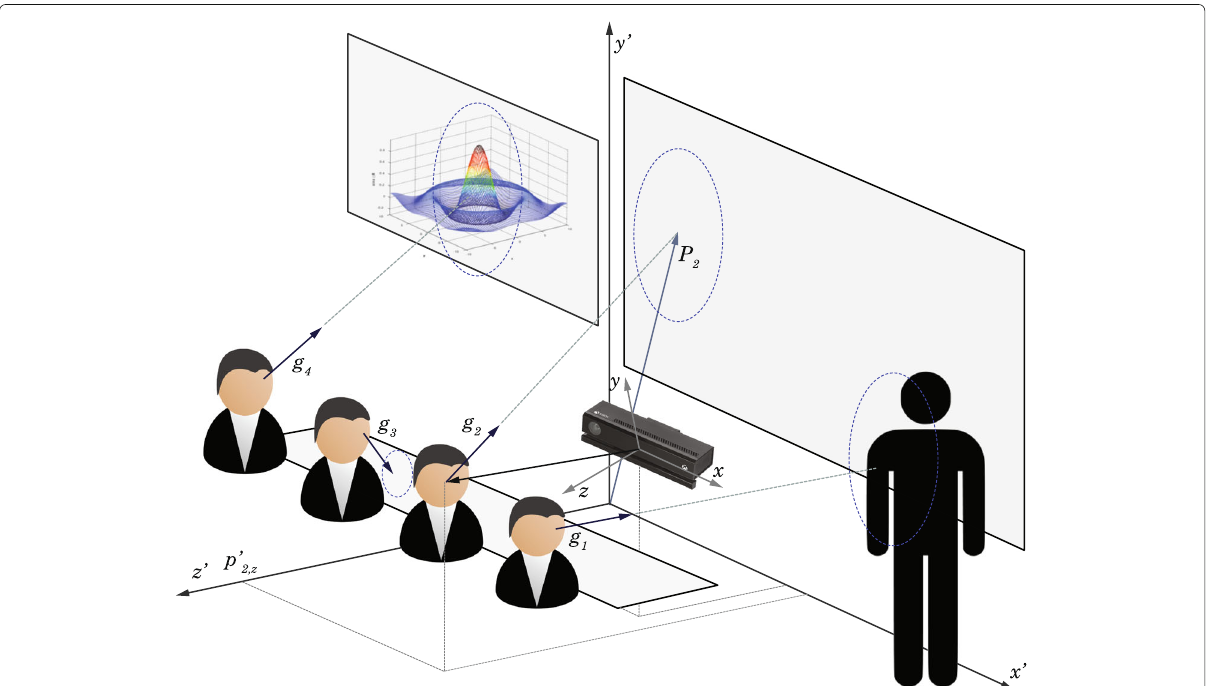
Fig. 1 Student observation in the classroom. The Kinect One sensor is recording behavior of multiple students to enable analysis of their gaze point and attention level during the